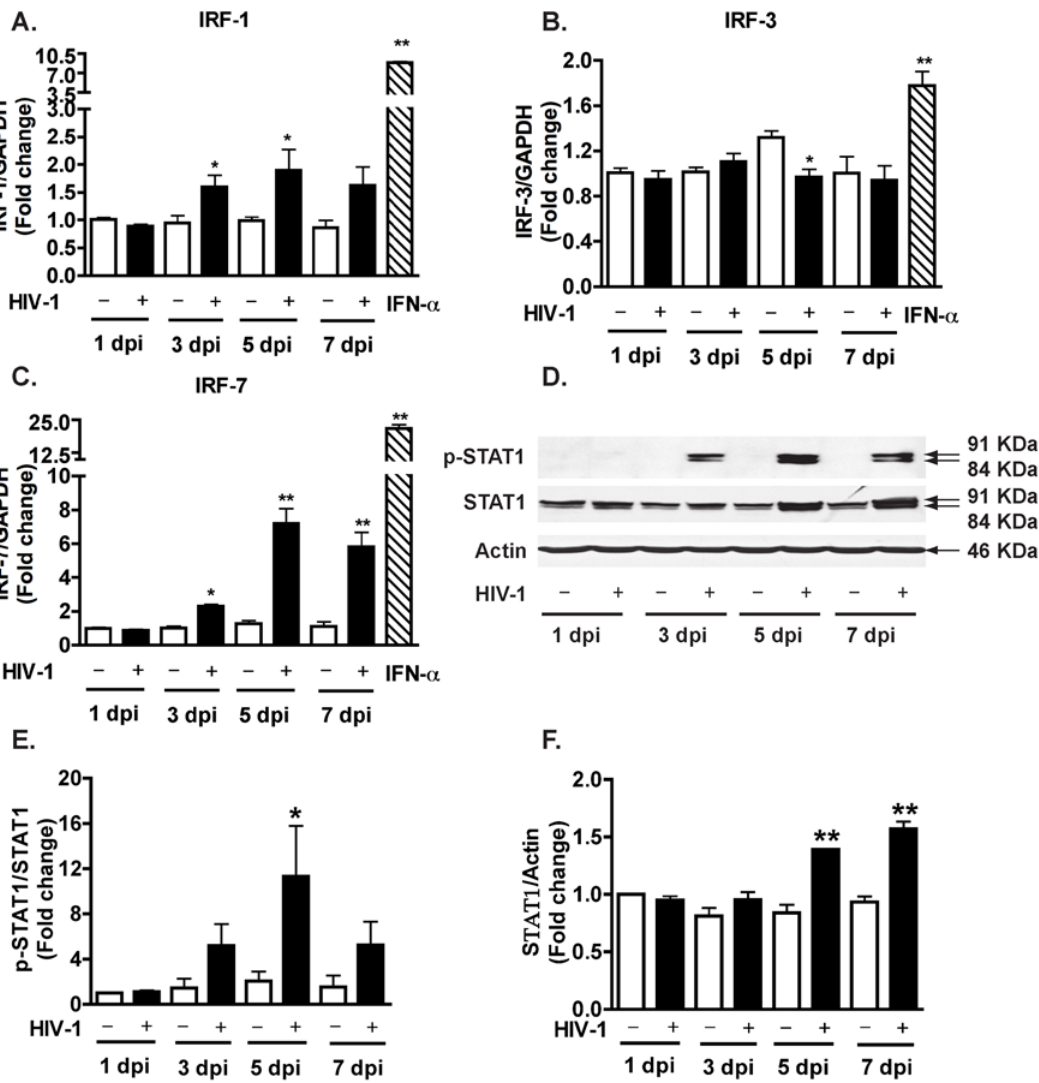
Figure 3. HIV-1 infection induces IRF-1 and IRF-7 gene expression and STAT1 phosphorylation at Tyr701 in macrophages. MDM were infected with HIV-1 and cell lysates and RNA were collected 1, 3, 5, and 7 days after infection. A–C. Real-time RT-PCR was used to detect IRF-1 (A), IRF- 3 (B), and IRF-7 (C). Open bars represent control MDM and solid bars represent HIV-1-infected MDM. IFN- a (1000 Units/ml) was also used to stimulate MDM for 24 hours, the effect on IRFs expression is shown in each panel as the diagonal striped bar. D. Phospho-STAT1 (p-STAT1, Tyr701) and total STAT1 were detected by Western blotting. b -actin was used as a loading control. E. Levels of p-STAT1 were normalized as a ratio of p-STAT1 to STAT1 after densimetrical quantification of panel D and shown as fold change relative to control (1 dpi). F. Levels of STAT1 were normalized as a ratio of STAT1 to b -actin and shown as fold change relative to control (1 dpi). Results are shown as the average 6 SEM in experiments performed with three different donors. *, p , 0.05 compared with day-matched control. **, p , 0.01 compared to day-matched